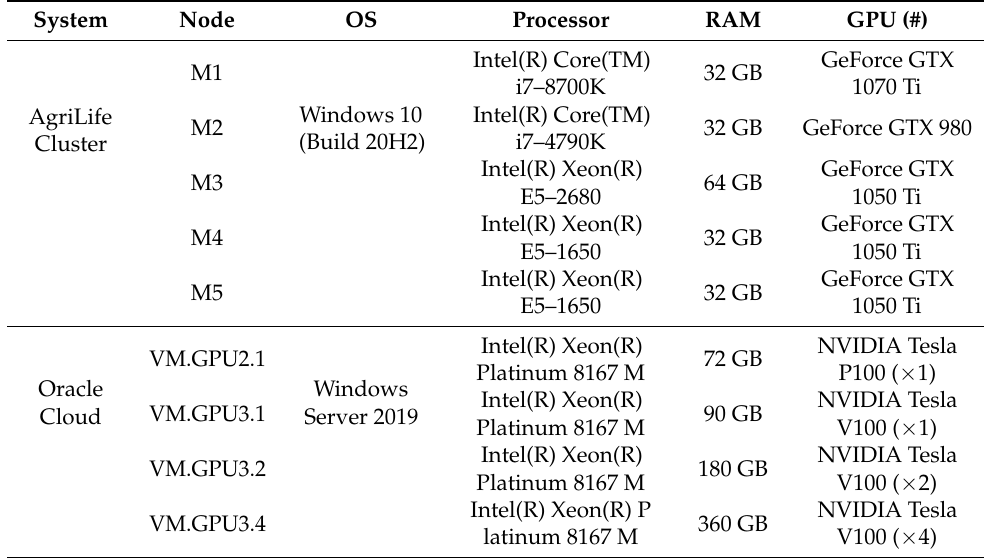
Figure 1. Cluster architecture of ( a ) the ALC and ( b ) the OCC. Nodes and network storage can be communicated through network switching internally without the internet in ALC. All components in the OCC had their own IP address (IPv4) to use the public internet for communication. Table 2. Summary of Hardware Specification of nodes in AgriLife Cluster and